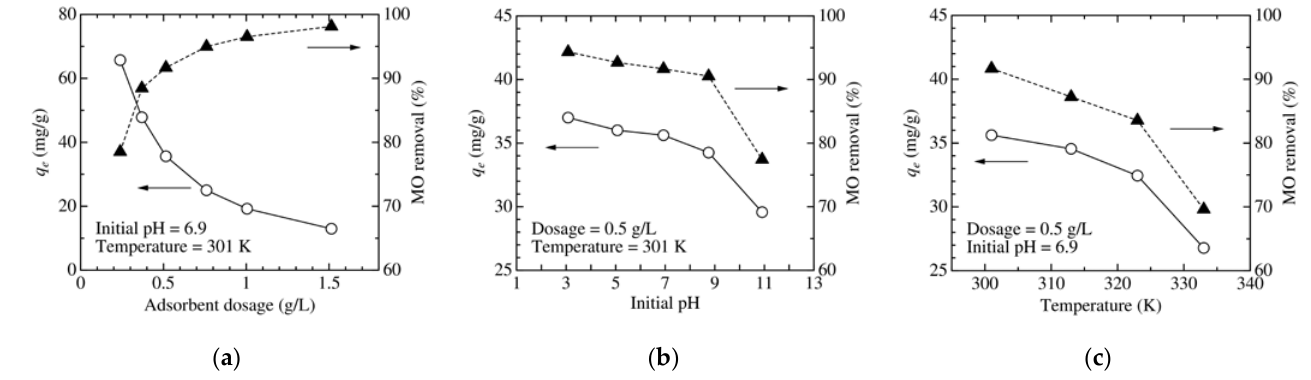
Figure 9. Change in MO equilibrium adsorption capacity of the DA5 sample with ( a ) adsorbent dosage, ( b ) initial pH, and ( c ) temperature (initial concentration = 20 mg/L).